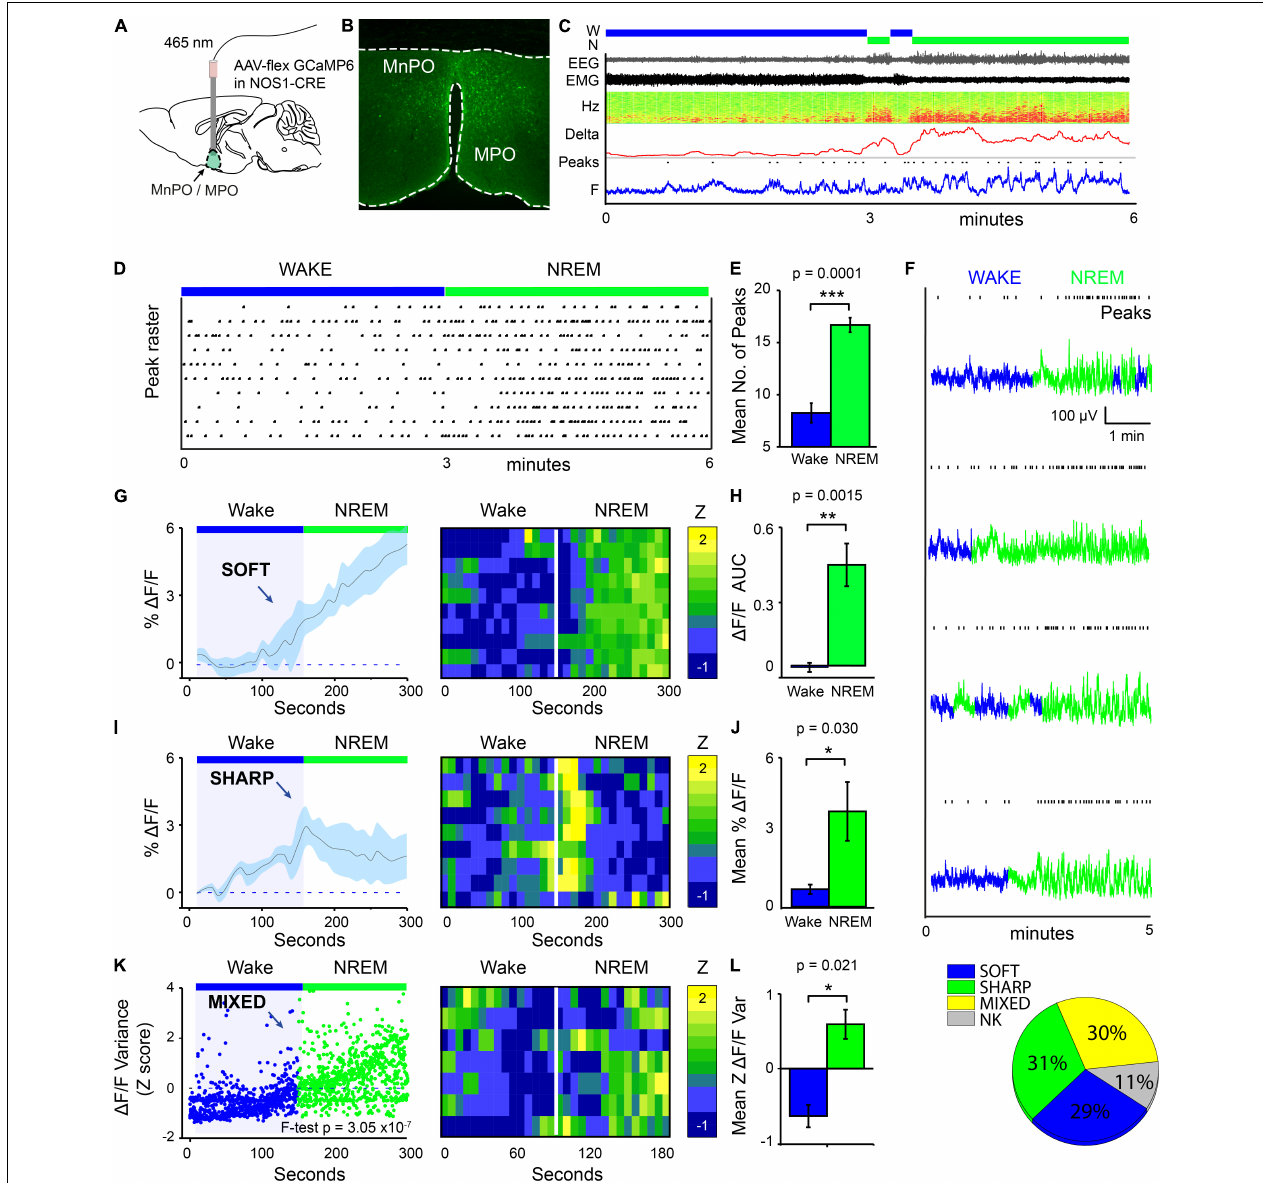
FIGURE 1 | MnPO/MPO hypothalamic NOS1 neurons are more active during sleep. Animals were recorded for 6 h across the light cycle from lights-off to lights-on to facilitate a distribution of sleep states. Transitions are shown over 300 s. (A) Schematic for the photometry recording at a 5-mm depth and an example of the GCaMP6 expression site in a Nos1-MnPO/MPO-GCaMP6s mouse. (B) Expression of GCaMP6s in neurons in the MnPO/MPO hypothalamus as detected by immunocytochemistry with GFP antisera. (C) Example transition from wake to NREM over a 6-min interval. Also shown are scored sleep states (Wake, W; NREM, N; REM, R), Filtered EEG and EMG, spectrogram of power in the frequency domain over time (Hz), Delta power (1–4 Hz) with a 5-s root mean square (RMS), raw photometry signal (labeled F) and automated peak counting on the photometry signal (Peaks). (D) A raster plot of automated spike counting from calcium photometry signals across wake to NREM transitions. (E) Area under the curve ( (cid:49) F/F) between wake and NREM for soft transitions in calcium signal (Paired t -test, n = 5, p = 0.0001). (F) Raw photometry data with paired automated peak counting for four example transitions over 5 min, colored by sleep state. Wake is shown in blue and NREM is shown in green. Peaks in calcium are marked above each trace. (G) The average (cid:49) F/F in calcium signal for soft-type transitions that increase across wake-NREM transitions and ten example transitions represented as a heatmap. (H) (cid:49) F/F Area under the curve between wake and NREM for soft transitions (Paired t -test, n = 5, p = 0.002). (I) The average (cid:49) F/F for sharp-type increases in calcium signal in wake-NREM transitions before returning to baseline, followed by ten example transitions represented as a heatmap. (J) Mean (cid:49) F/F of the calcium signal between wake (baseline) and NREM (peak) for sharp transitions (Paired t -test, n = 5, p = 0.004). (K) The z -score of (cid:49) F/F variance for mixed-type transitions in calcium signal that increase across wake-NREM transitions ( F -test of all pooled transitions, p = 3 × 10 − 7 ). Shown alongside ten example transitions in the calcium signal represented as a heatmap. (L) Quantification of variance in the (cid:49) F/F calcium signal in across mice (Paired t -test, n = 5, p = 0.021). (M) Proportion of each transition in calcium signal type (soft increase, sharp increase, mixed increase) found in all wake to NREM transitions. Transitions in calcium signal that could not be classified are labeled NK. The Benjamini-Hochberg procedure was used to account for multiple comparisons at a false discovery rate of 5%. * P < 0.05, ** P < 0.01, *** P < 0.001.